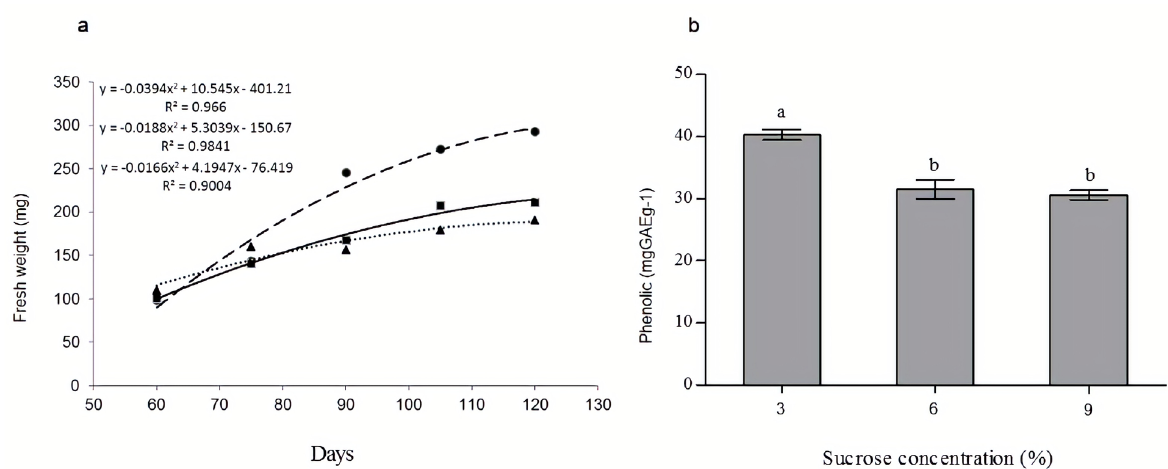
Figure 3. a) Growth parameters of I. paraguariensis callus culture supplemented with increasing sucrose concentrations. Callus growth was expressed as milligrams of fresh weight. b) Total phenolic accumulating after 120 days of culture of I. paraguariensis. Data are the mean ± SE ( n = 10) ( ) 3% sucrose; ( ) 6% sucrose; ( ) 9% sucrose. Means with different letters are significantly different at the 5% level of probability using Tukey’s multiple range test. The vertical bars represent the standard error of five